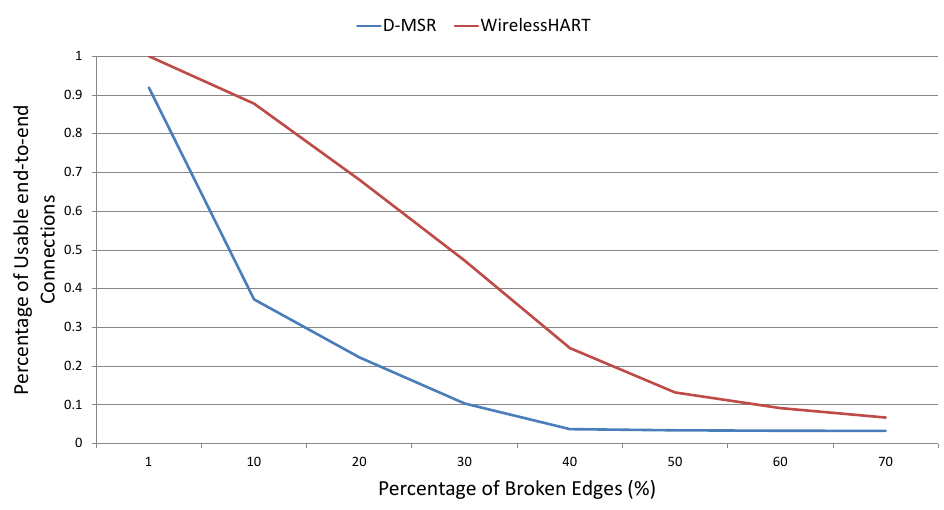
Figure 25. Reliability of the end-to-end